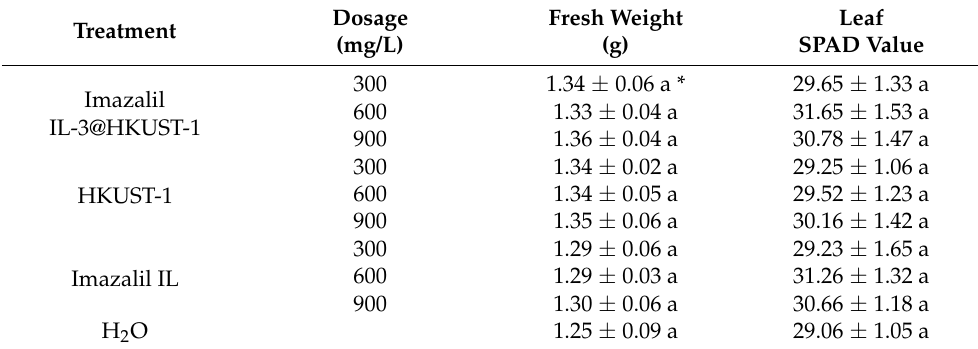
* Mean values of fresh weight and leaf SPAD within each column followed by same letters are not significantly different at p < 0.05, n =